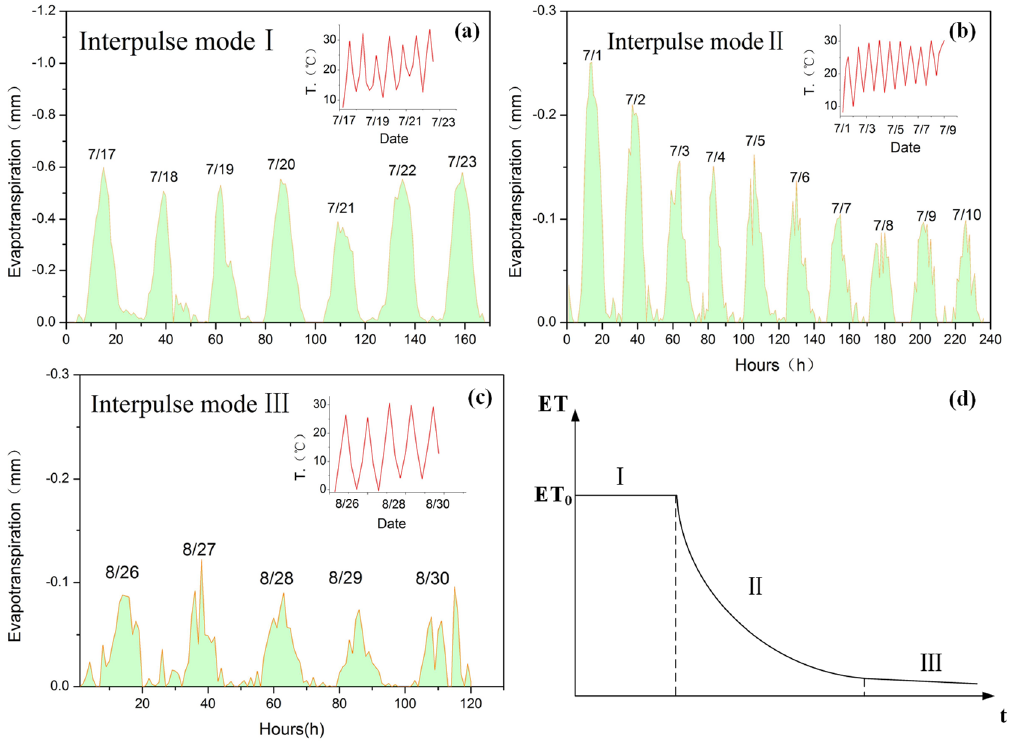
Figure 8. Interpulse mode of ET a . ( a ) Interpulse mode I: Stable evapotranspiration mode (sufficient water content condition); ( b ) Interpulse mode II: Attenuated evapotranspiration mode (water stress appears); ( c ) Interpulse mode III: Stable evapotranspiration mode (extreme dry condition). The numbers in the graph ( a ), ( b ), ( c ) refer to the respective dates; and, ( d ) Scheme of interpulse evapotranspiration.